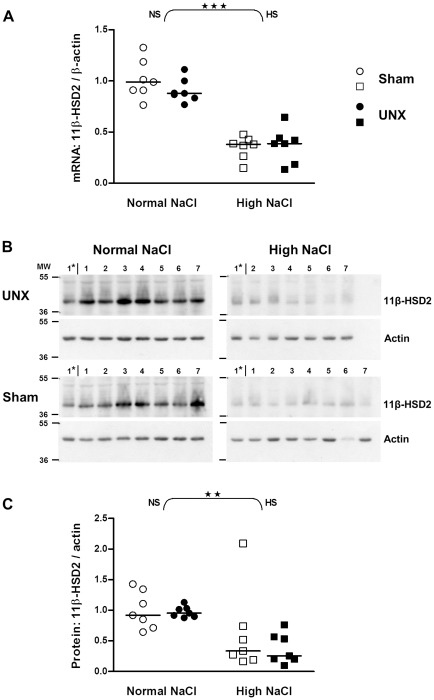
Impact of salt intake on 11β-hydroxysteroid dehydrogenase type 2 expression in the colon of control and UNX rats.A: mRNA expression in epithelial cells isolated from colon (real-time PCR). Values were normalized with endogenous β-actin mRNA expression. Results were quantified relative to the mean of the sham-operated, normal salt group. B: Western blots showing protein in epithelial cells isolated from colon. Lanes 1–7: Rat colon samples; Lane 1*: Sample 1 of UNX high NaCl group was loaded on each gel as a standard for comparison between blots; MW: molecular weight. C: Amount of proteins relative to control rats (sham-operated, normal salt). Values were adjusted with the colon protein sample on lane 1* and normalized with the protein expression of actin. The horizontal line is the median (n = 7). ★★, P≤0.01; ★★★, P≤0.001 indicate the effect of salt analyzed by two-way ANOVA (curly brackets; NS: normal salt; HS: high salt).